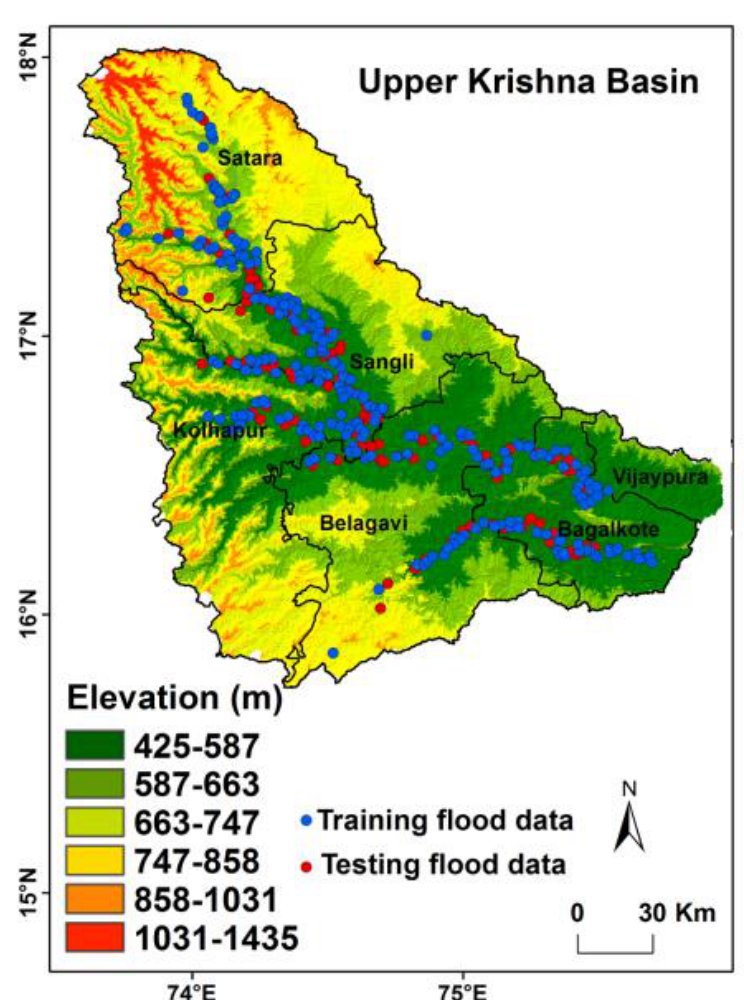
Figure 3. Flood locations in the UKB (August 2019).